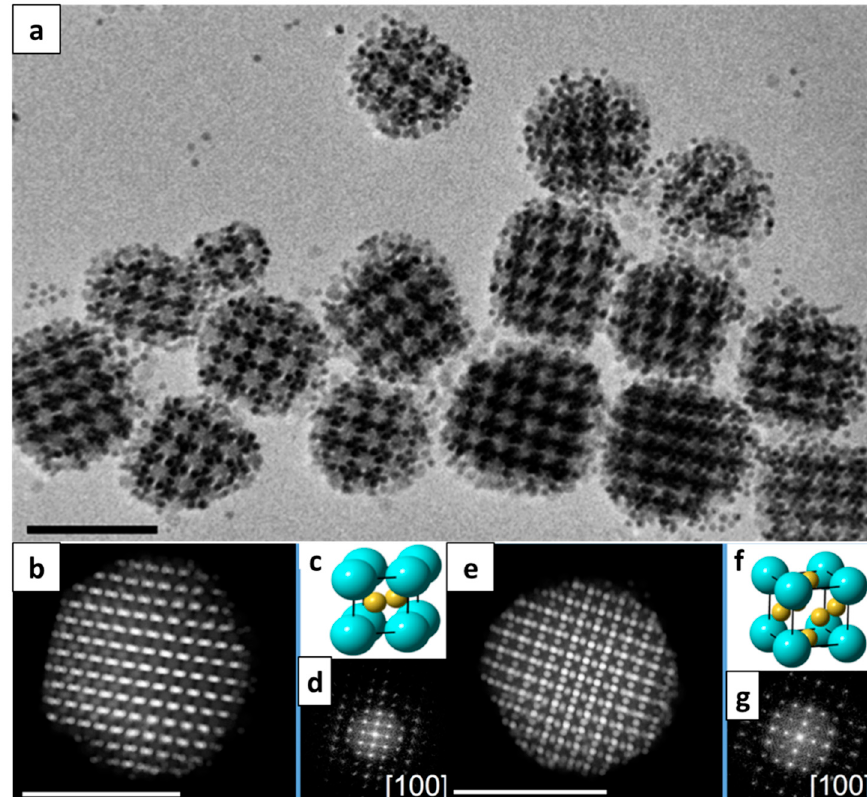
Figure 8. ( a ) A TEM image of ico-NaZn 13 -type supracrystals. High-angle annular dark field scanning TEM (HAADF-STEM) images of ( b ) AlB 2 -type supracrystals and ( e ) AuCu 3 -type supracrystals. ( c , f ) The unit cells of the AlB 2 -type lattice and AuCu 3 -type lattice, and ( d , g ) their fat Fourier transformation (FET) patterns. The scale bar in all the TEM images is 100 nm. (Reproduced with permission from [41]. Copyright American Chemical Society, 2018)